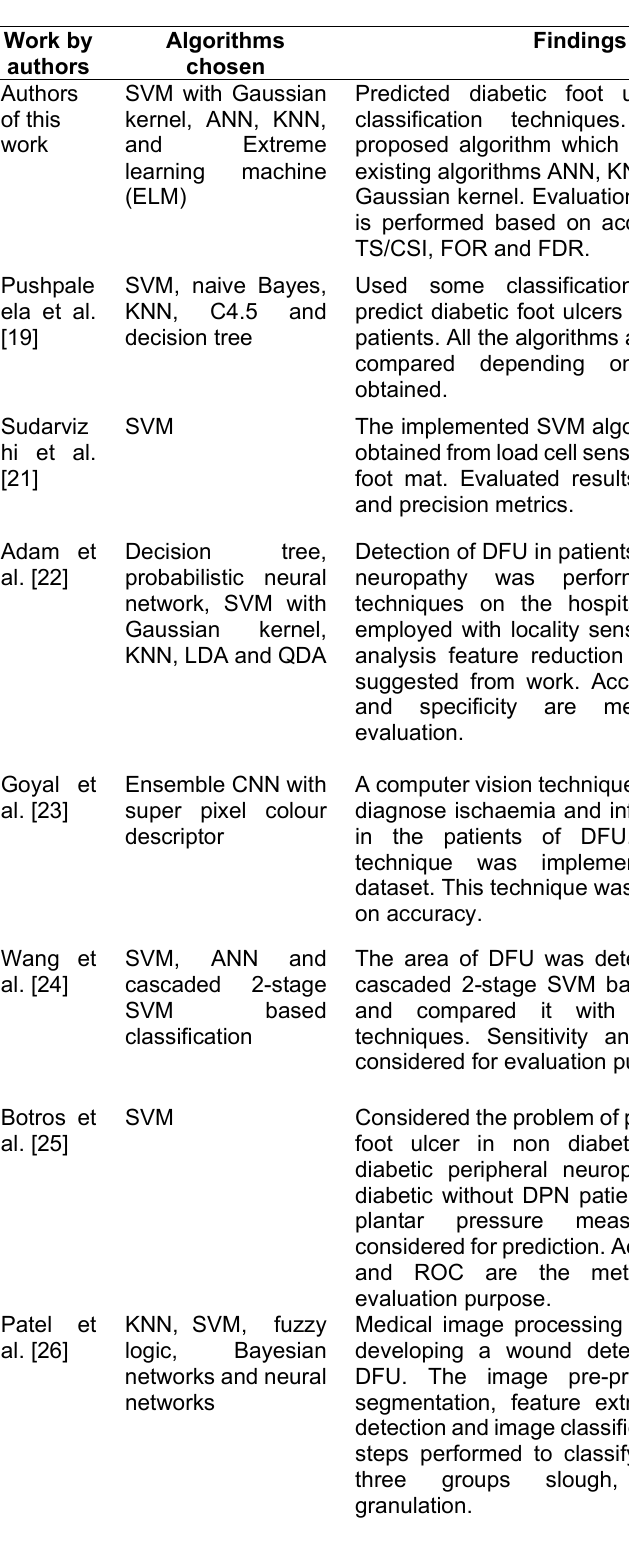
Table 6. Comparing proposed work with similar literature